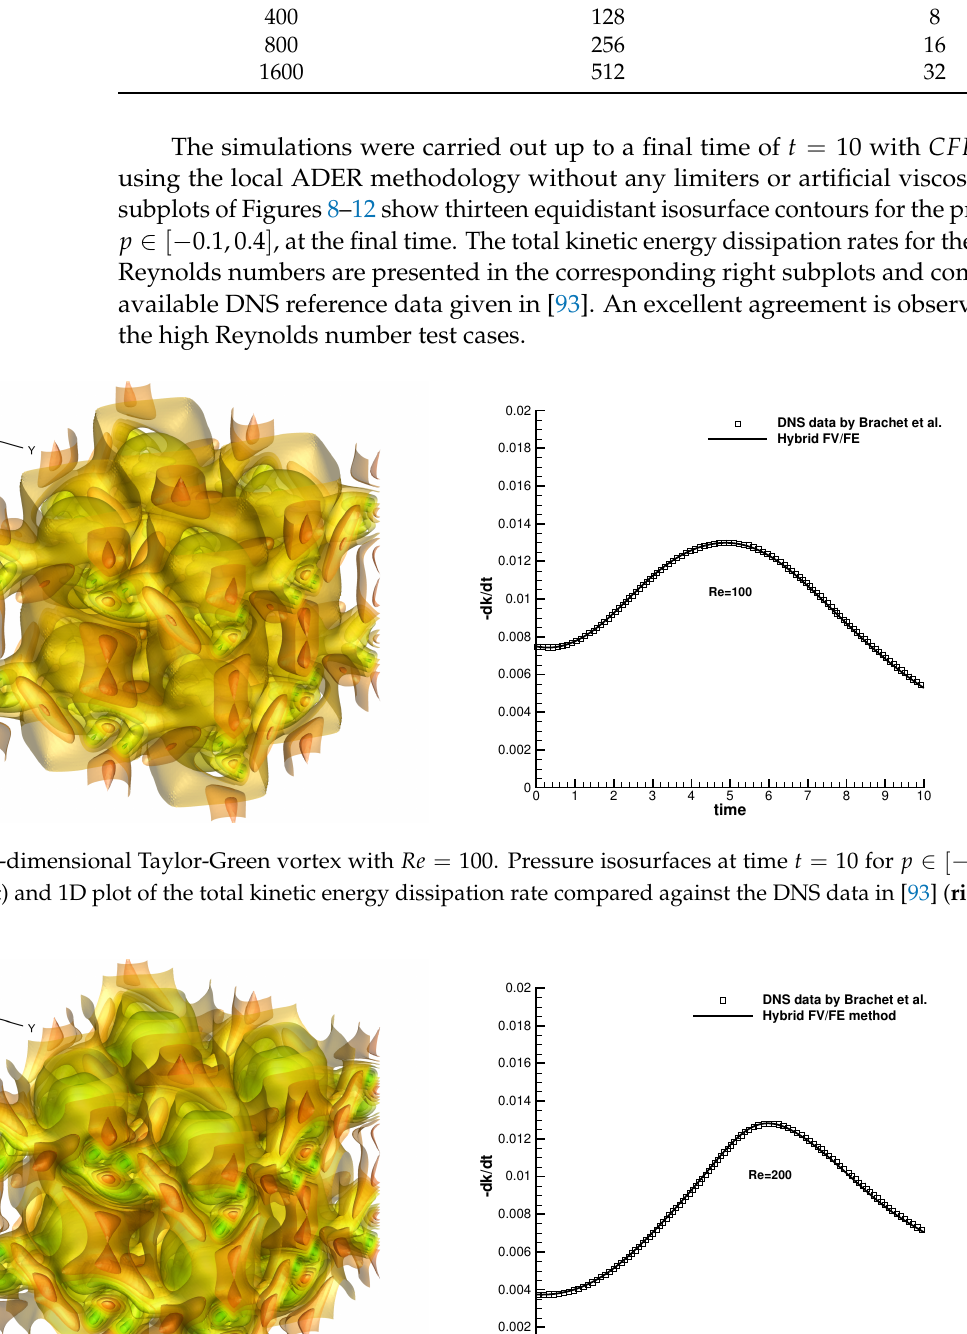
Figure 9. Three-dimensional Taylor-Green vortex with Re = 200. Pressure isosurfaces at time t = 10 for p ∆ p = 0.025 ( left ) and 1D plot of the total kinetic energy dissipation rate compared against the DNS data in [93] ( right